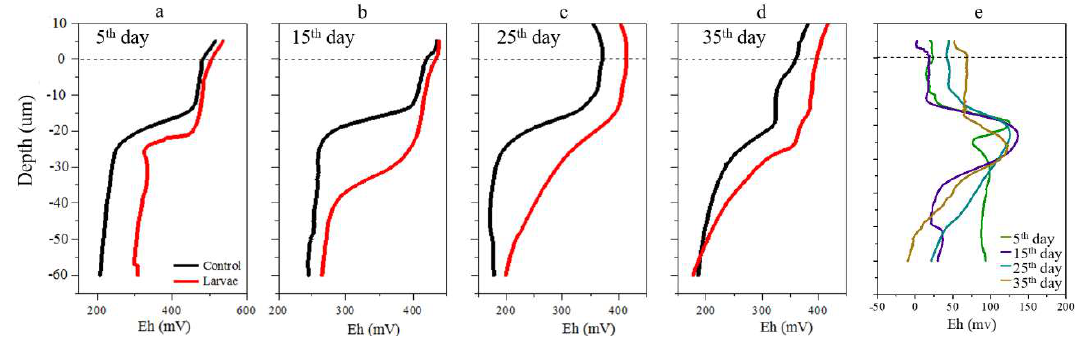
Figure 2. Eh profiles in sediment cores of the control and the Chironomid larvae treatment. The horizontal dashed line at zero indicates the sediment–water interface (SWI); over the line indicates overlying water; under the line indicates sediments. (e) Eh changes in treatment minus changes in control on the 5th ( a ), 15th ( b ), 25th ( c ) and 35th ( d ) day, respectively.